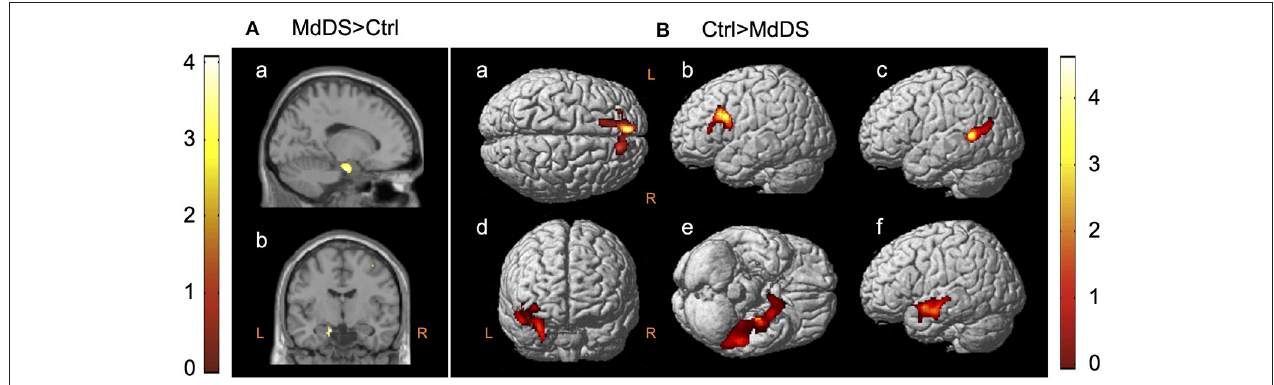
FIGURE 1 | 18 F-FDG PET contrasts between mal de débarquement syndrome (MdDS) and controls (Ctrl) with differences of z > 3.3. Clusters are shown at z > 2.57 for the MdDS > Ctrl contrast and at z > 1.96 for the Ctrl > MdDS contrast for better visualization. Coordinates of peak significance are indicated in parentheses. In SPM, negative X -values are on the left and positive on the right. (A) MdDS > Ctrl: left entorhinal cortex/amygdala [Montreal Neurological Institute (MNI): − 14, − 8, − 22], (a) sagittal view and (b) coronal view. (B) Ctrl > MdDS: (a) left superior medial gyrus (MNI: − 8, 52, 36), (b) left middle frontal gyrus (MNI: − 32, 18, 30), (c) left middle temporal gyrus (MNI: − 50, − 52, 8), (d) right insula/amygdala (MNI: 30, − 2, − 26 and 40, 2, − 8), (e) left inferior temporal gyrus (MNI: − 52, − 38, − 24), and (f) left superior temporal gyrus (MNI: − 52, 0, − 14). Figure adapted from Cha YH et al., PLOS One 2012